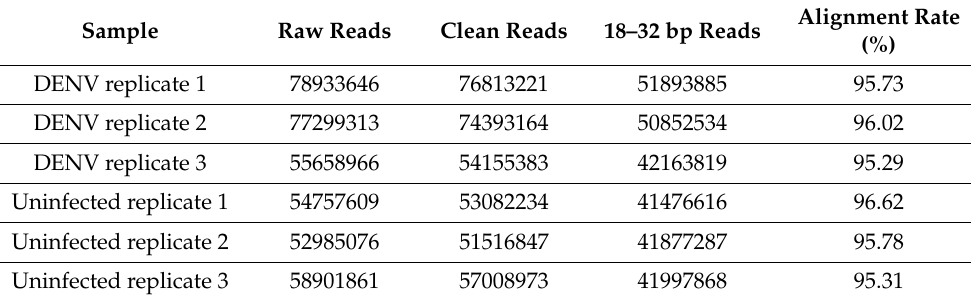
Table 1. Mapping statistics of small RNA reads generated in this study.